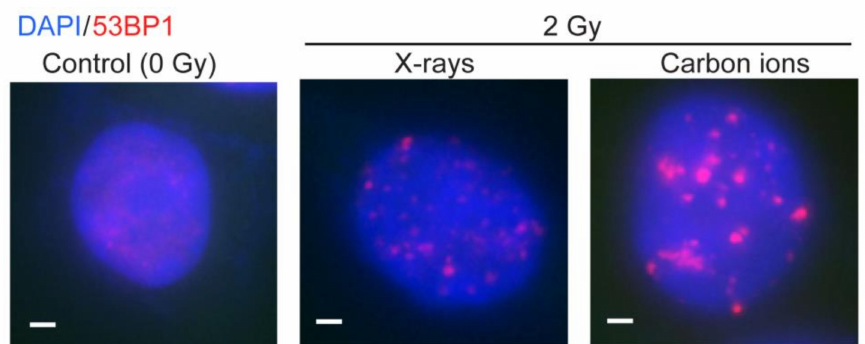
Figure 2. Radiation-induced 53BP1 foci. RKO colon carcinoma cells were mock-treated or irradiated with X-rays or carbon ions. Nuclei were stained with DAPI (blue) and 53BP1 foci (red) were detected by immunofluorescence microscopy. White scale bars are 1 nm. These previously unpublished images were collected during a study comparing the induction of delayed homologous recombination by low or high LET(linear energy transfer) radiation [108].